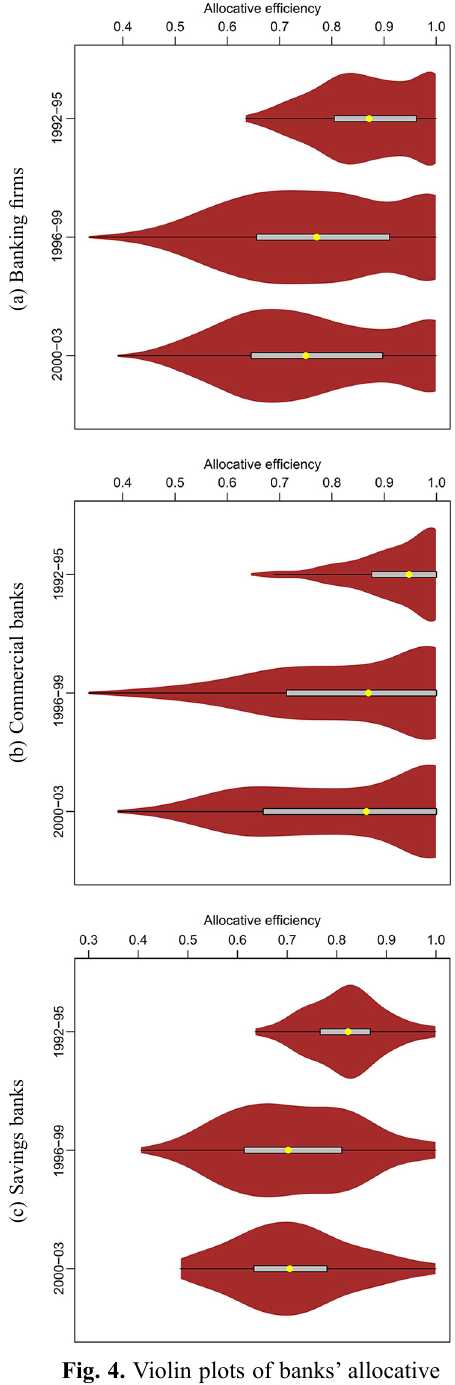
Fig. 4. Violin plots of banks’ allocative efficiency,